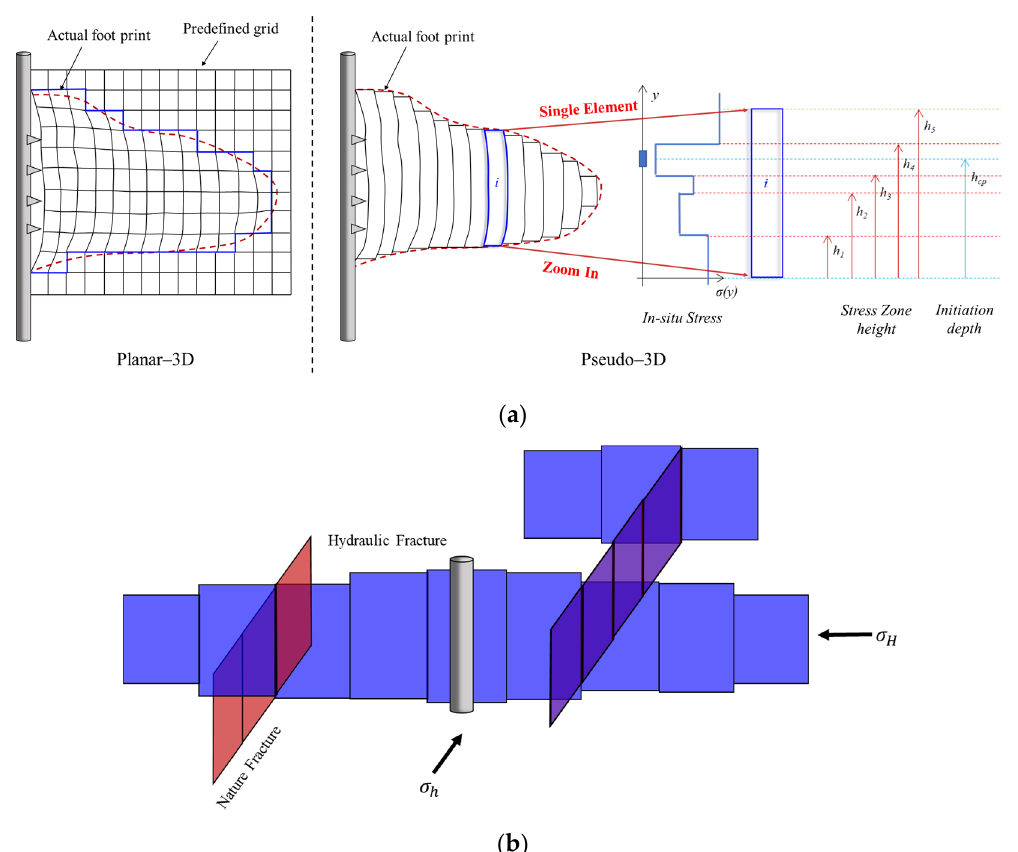
Figure 5. ( a ) Difference between a pseudo-3D model and planar-3D model (Cohen et al., 2017); ( b ) diagram depicting hydraulic and pre-existing natural fractures.